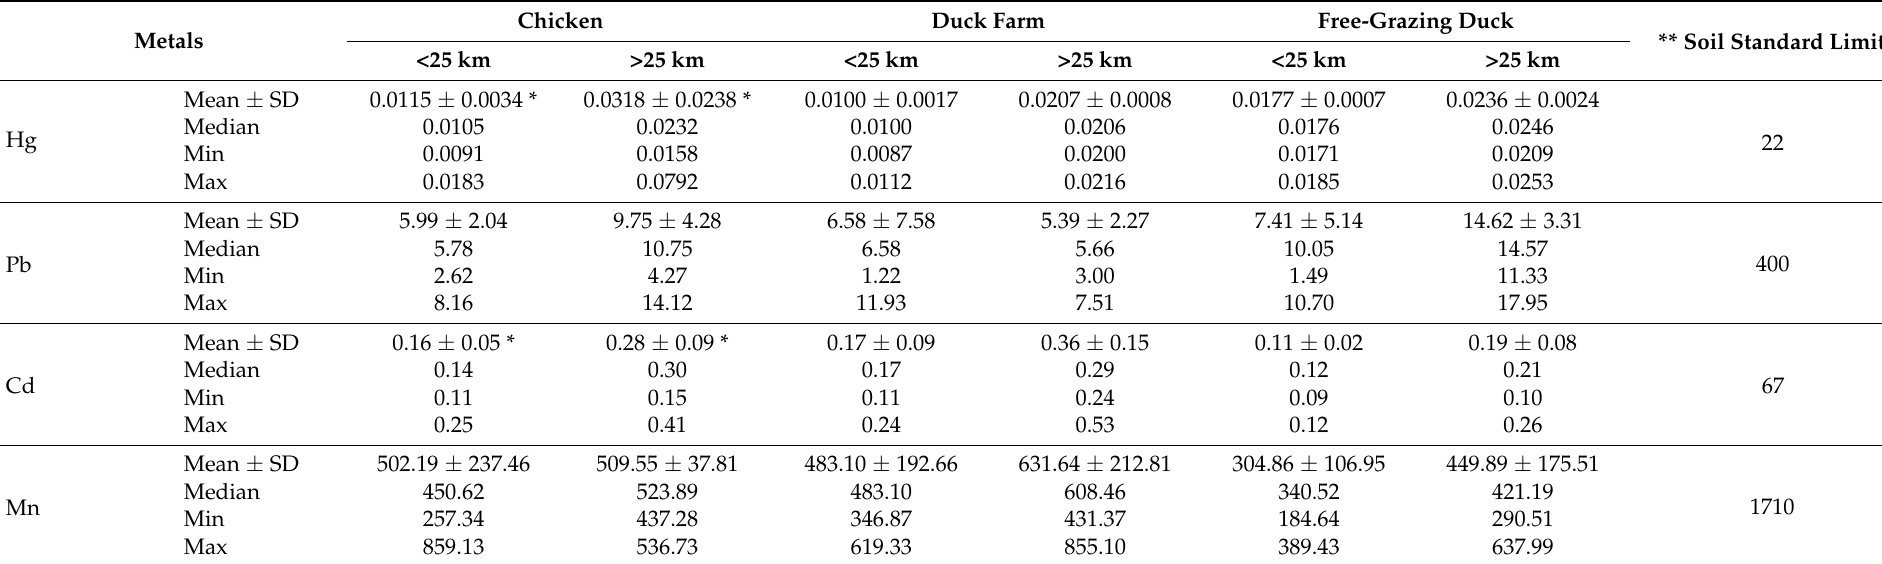
Table 9. Mean ± SD, the median, minimum, and maximum values of Hg, Pb, Cd, and Mn concentrations in soil (mg kg − 1